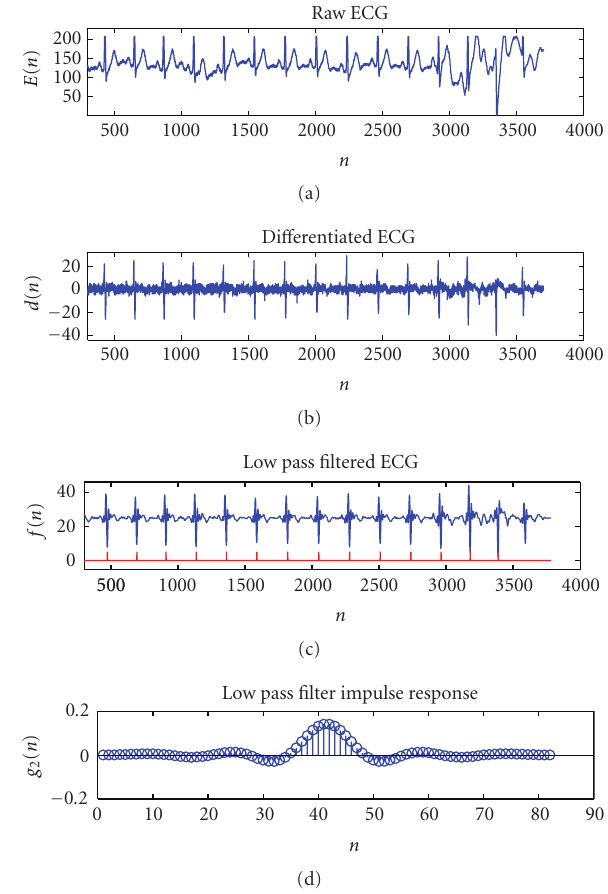
Figure 5: (a) Raw measured ECG signal, (b) ECG signal d ( n ) after the di ff erentiator, (c) ECG signal f ( n ) after lowpass filtering. The detected R peaks are overlaid on the plot, and (d) impulse response of the lowpass filter, g 2 ( n )